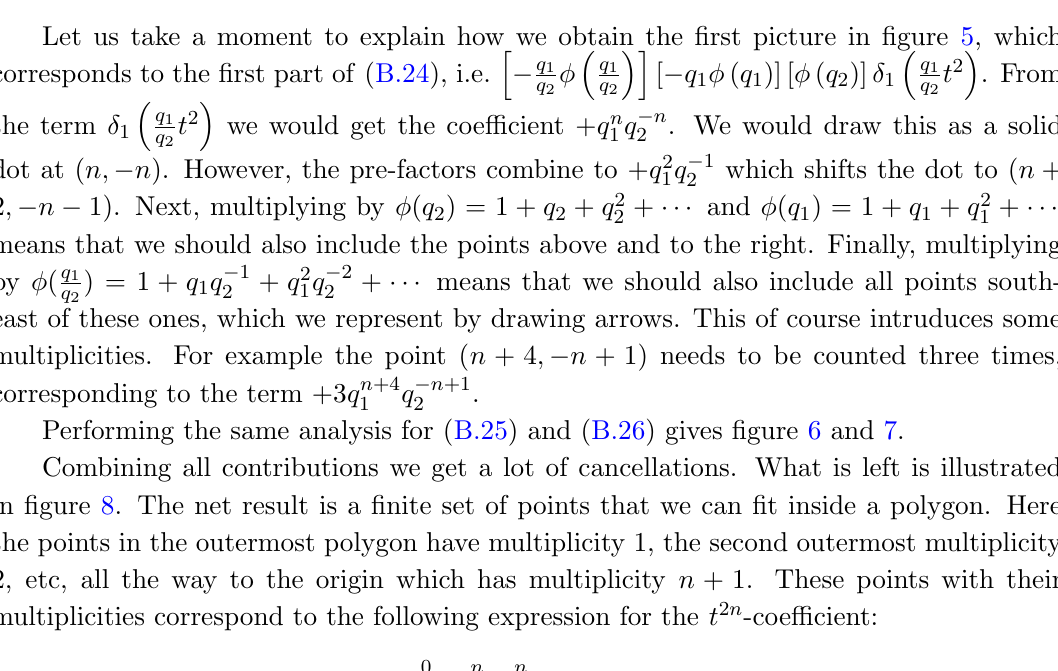
Figure 7 . Pictorial representation of the coe(cid:14)cients of t 2 n , n (cid:21) 0, coming from the two terms in